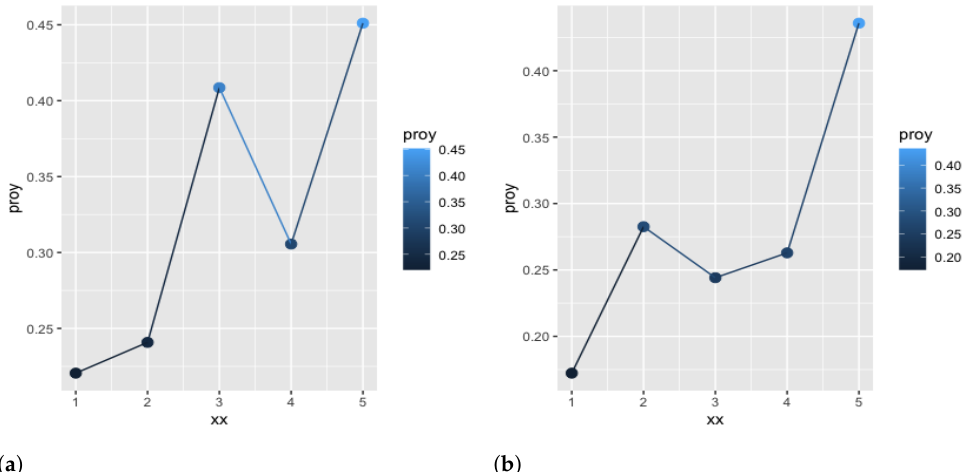
Figure 5. ( a ) Representation of the projection of the object “plastic” on the universe U . ( b ) Represen- tation of the projection of the object “chair” on the universe U